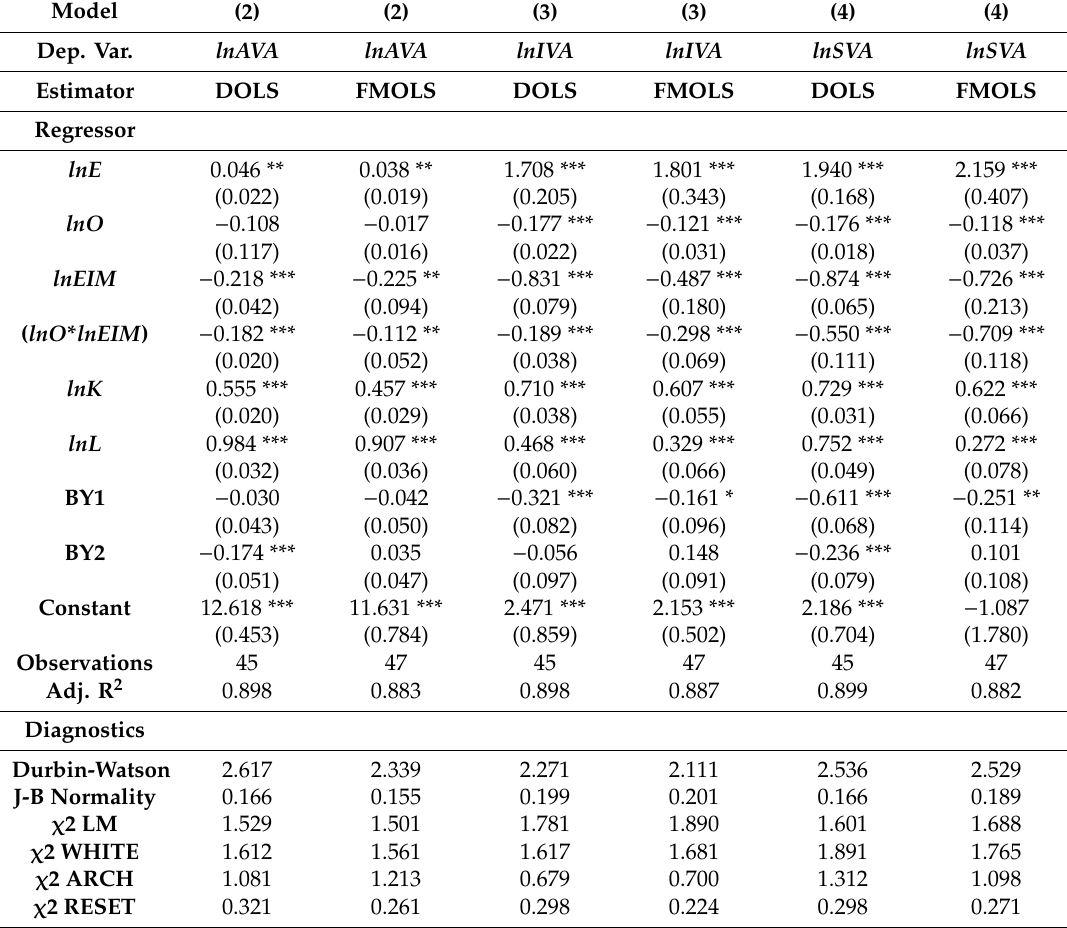
Table 6. The long-run elasticity estimates in the context of models